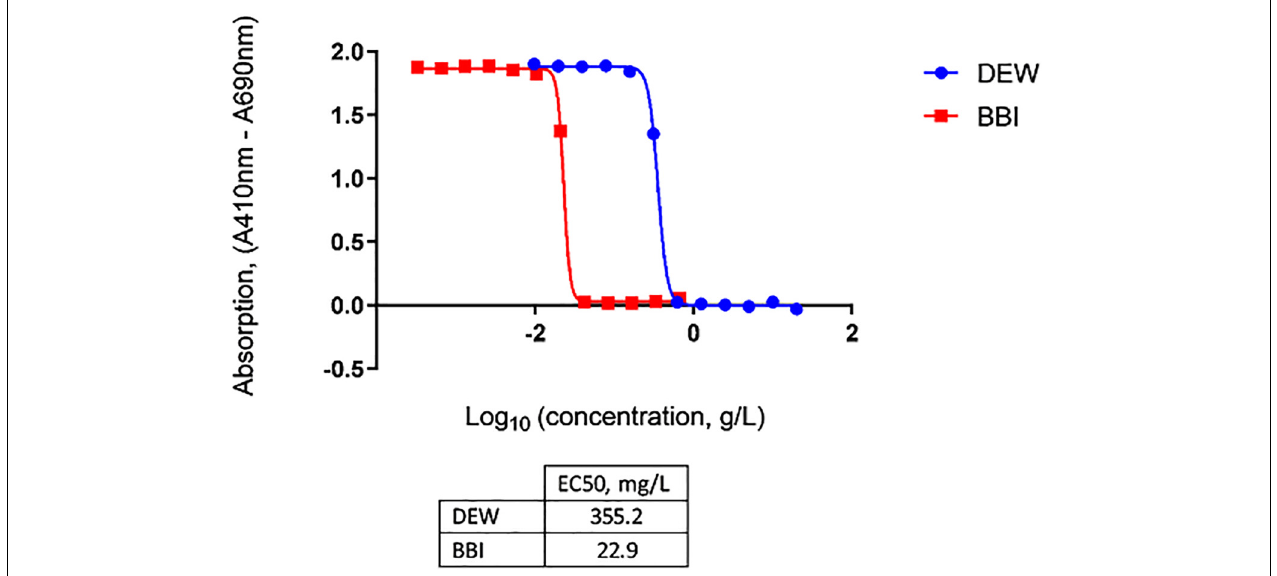
FIGURE 3 | Inhibition of human trypsin with DEW and purified BBI determined by N α -Benzoyl- DL -Arginine- p -Nitroanilide (BAPNA) colorimetric assay. Concentrations of DEW and BBI that gave half-maximal inhibition of human trypsin (EC 50 ) are given in the